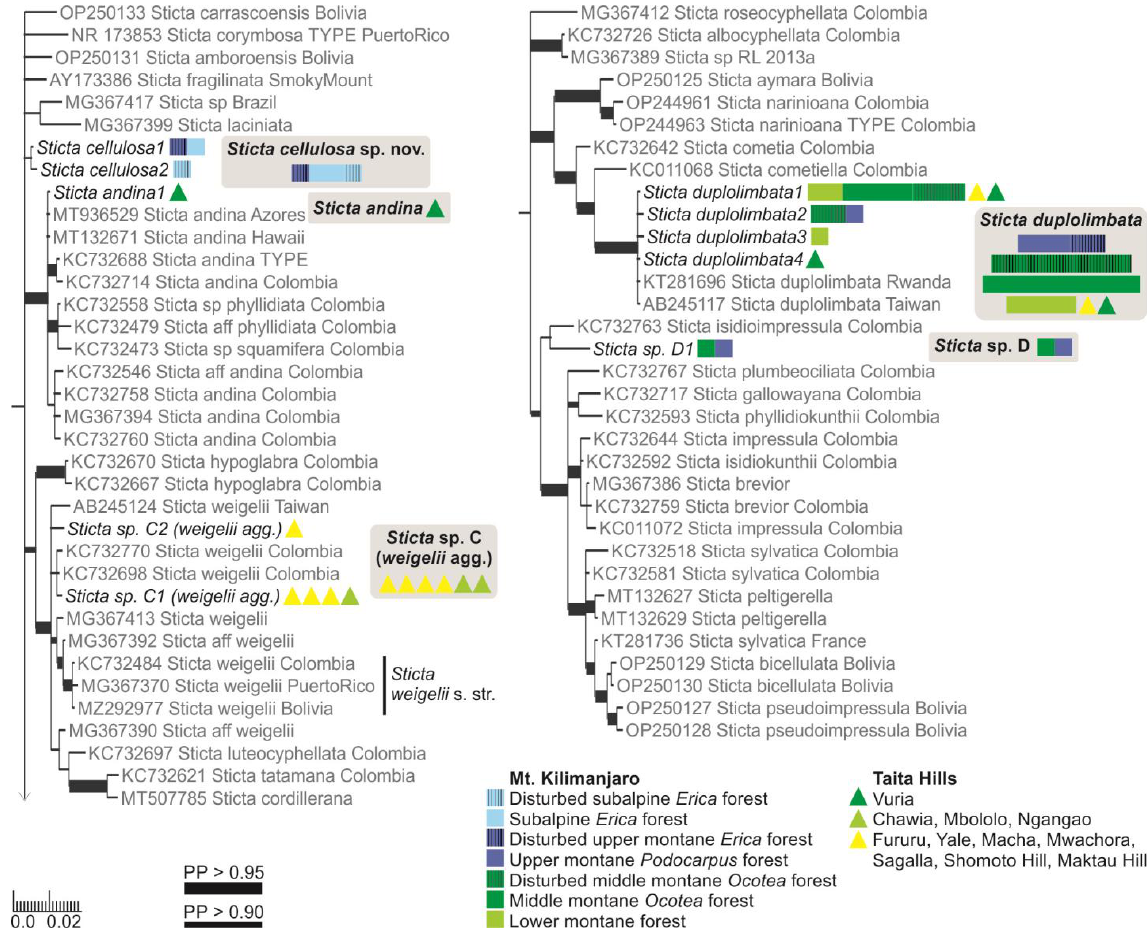
Figure 4. Clades with Sticta cellulosa , S. andina , Sticta sp. C (weigelii agg.), S. duplolimbata , and Sticta sp. D of the Bayesian tree of the genus Sticta based on the nuITS marker region (Figure S1D,E). The colored polygons (rectangle, triangle) in the tree show the distribution of the ITS variants in the studied regions and ecosystem types: On Mt. Kilimanjaro, the different habitats are indicated by color and grid; the width of the rectangle indicate the number of sample plots in which the taxon was present in each ecosystem type (square = 1). In the Taita Hills, each triangle indicates presence in one forest fragment. The grey boxes show the total abundance and distribution of the species, including also the data from unsequenced specimens. Stronger support (PP > 0.9) for a clade is in- dicated with a thicker branch. The scale refers to nucleotide substitutions per site.